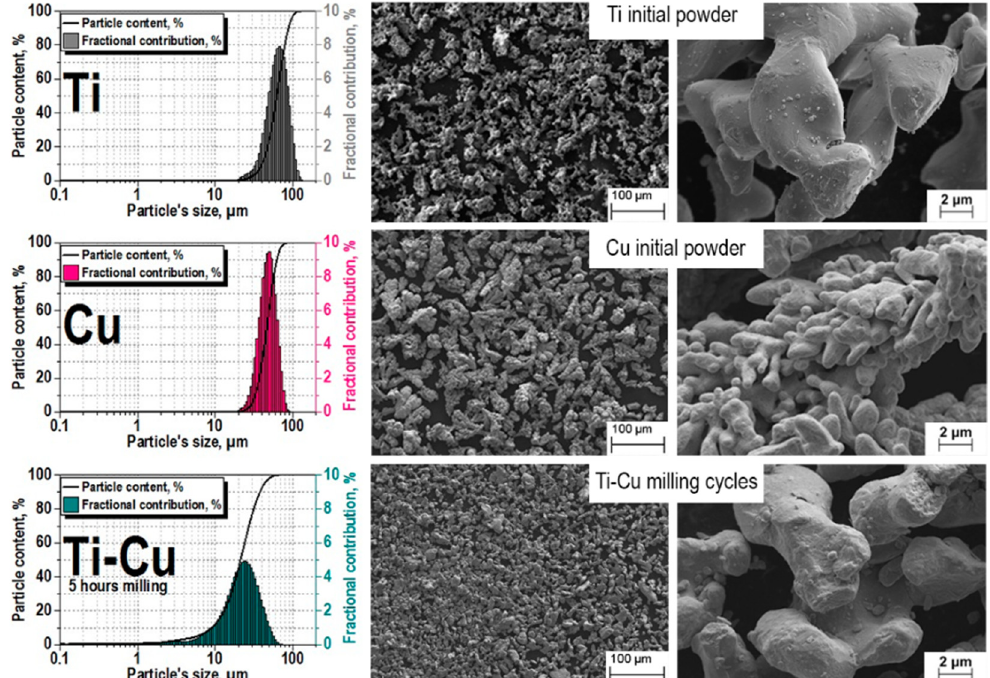
Figure 2. Powder particle sizes before and after grinding.